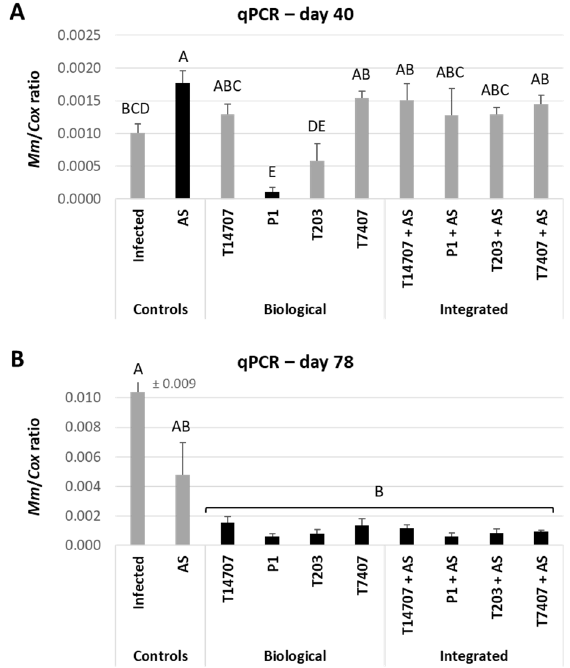
Figure 11. Real-time PCR-based monitoring of the relative amount of M. maydis DNA inside the plants’ roots. This evaluation was made in the open-enclosure trial at midseason ( A , day 40) and harvest ( B , day 78). The relative amount of M. maydis DNA ( Mm ) normalized to the cytochrome C oxidase DNA (Cox) in the plants’ roots is presented in the Y axis. Each value is a mean of 9–10 repetitions (plants per treatment). Error bars indicate standard error. Different letters (A–E) above the chart’s bars represent an ANOVA test significant difference ( p < 0.05).